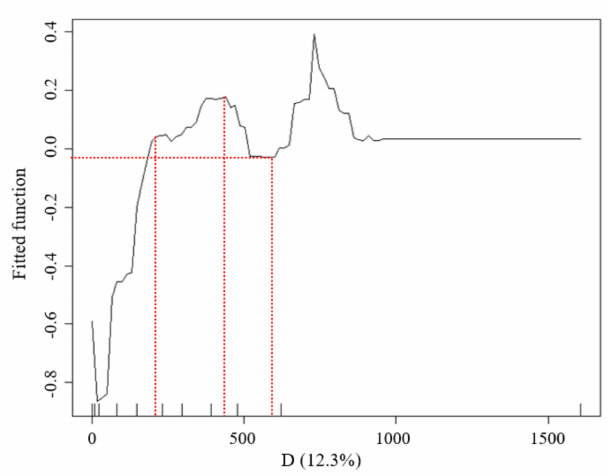
Figure 7. Relationship between the D factors and LST of the waterfront green space in the buffer zone of Width-I river corridors.